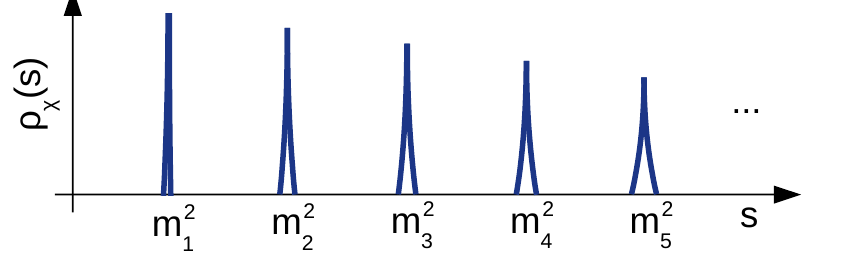
Figure 2 . A cartoon of a typical fermionic spectral density in the case of an in(cid:12)nite tower of massive fermions (KK